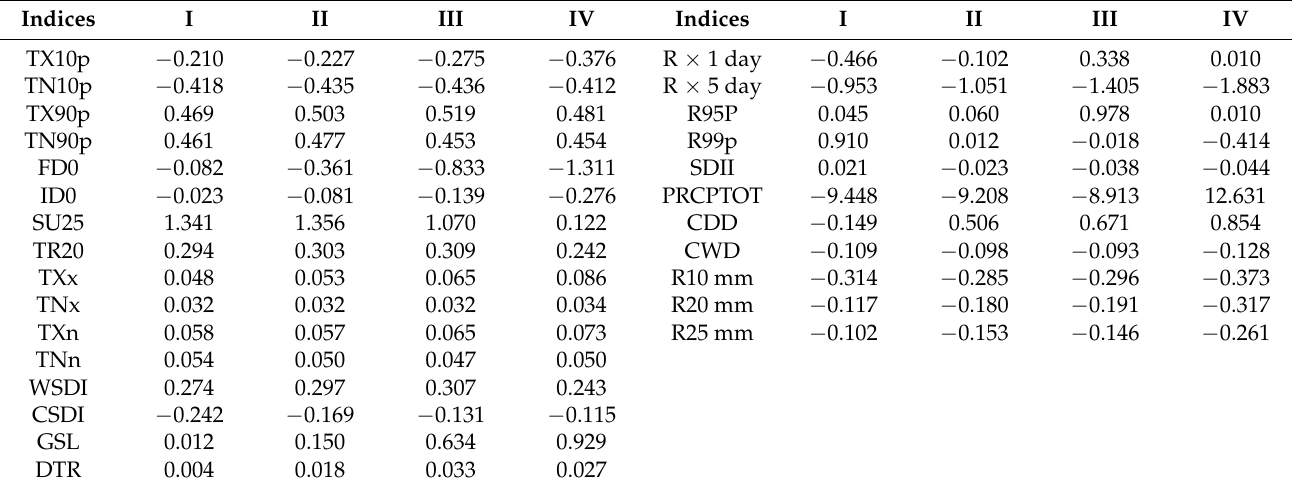
Table 4. The average trend coefficients of 27 extreme climate indices at different elevations.